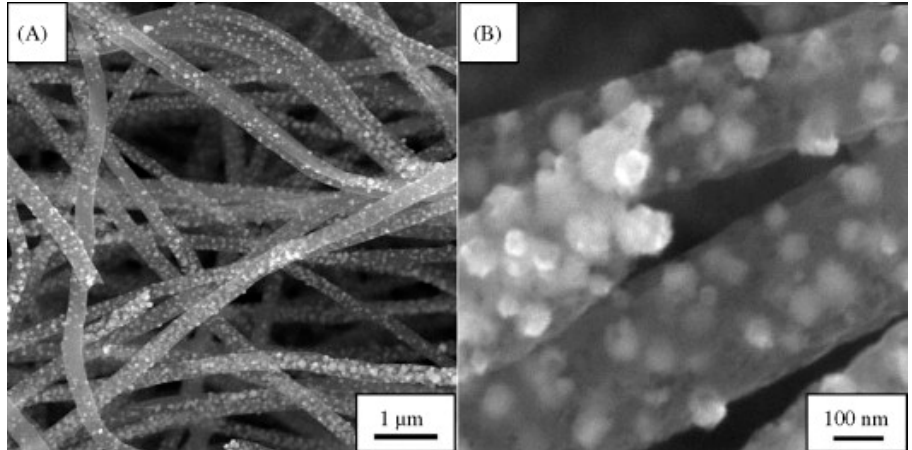
Figure 6. SEM images of the NiCF composite at ( A ) low and ( B ) high magnification [144]. Reprinted from the Analytica Chimica Acta, Vol 663, Yang Liu, Lei Zhang, Qiaohui Guo, Haoqing Hou, and Tianyan You, Enzyme-free ethanol sensor based on electrospun nickel nanoparticle-loaded carbon fiber paste electrode, 153–157, Copyright (2010) with permission form Elsevier.